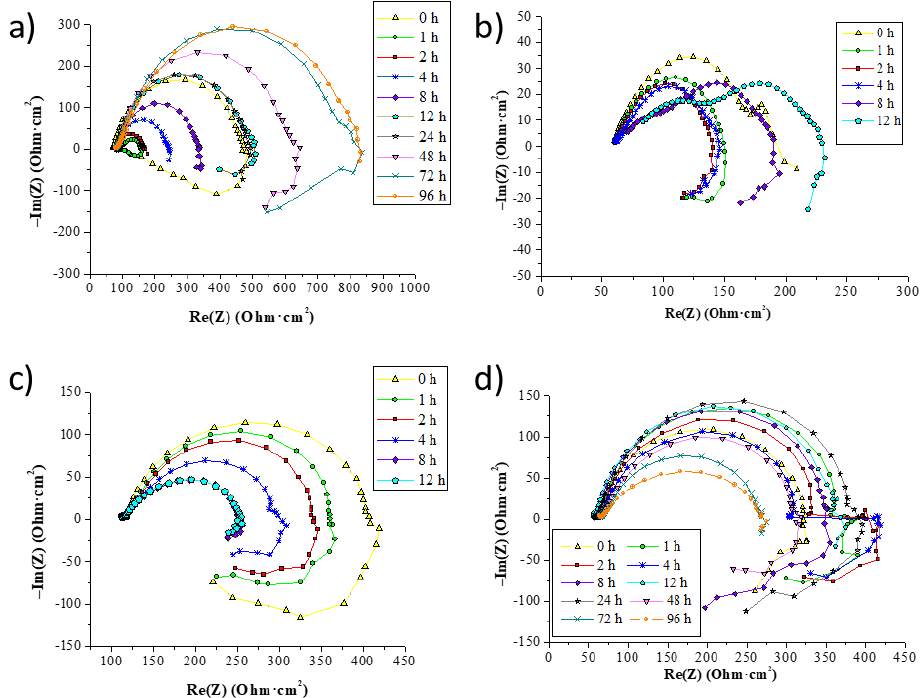
Figure 3. Nyquist plots for pure wrought Mg and Mg CS in 0.9% NaCl: ( a ) wrought pure Mg (different axis scale); ( b ) 500 MPa/RT; ( c ) 100 MPa/400 °C; ( d ) 500 MPa/400 °C.